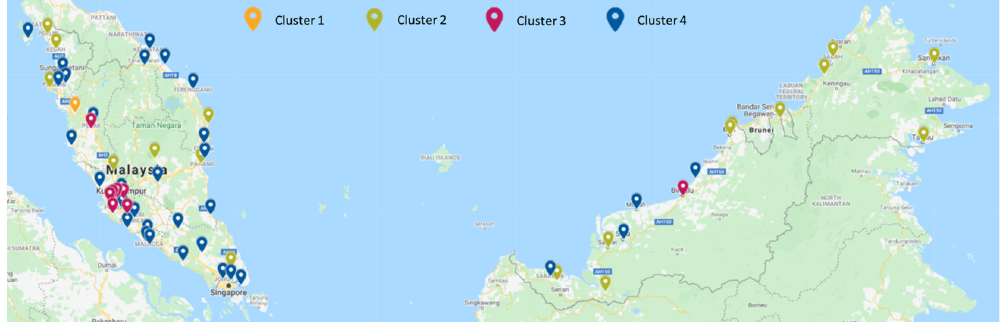
Figure 19. Air monitoring stations’ locations colored according to clusters for PM 10 daily maximum time series data with DTW and PAM as its clustering algorithm.